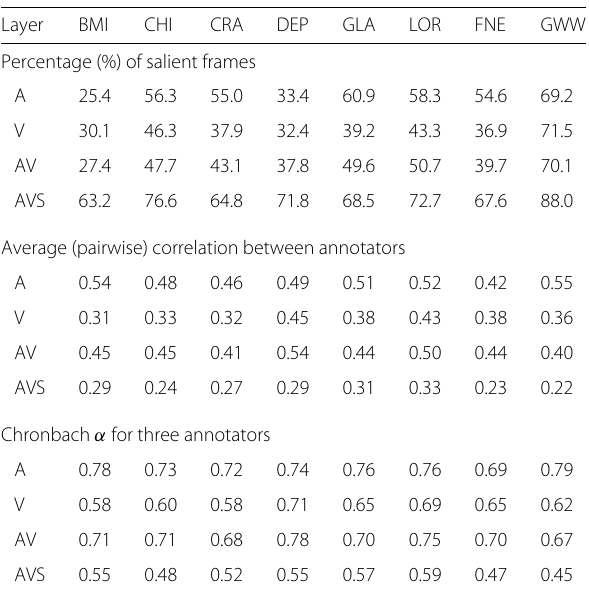
Table 2 Statistics for COGNIMUSE database (Hollywood movies and GWW) annotated with salient events